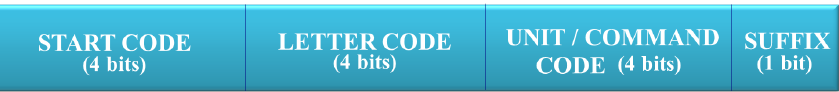
Figure 3. X10 data frame.